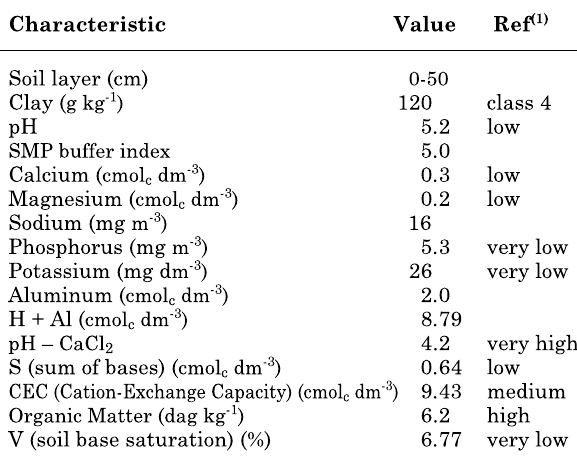
Table 1. Chemical and physical characteristics of